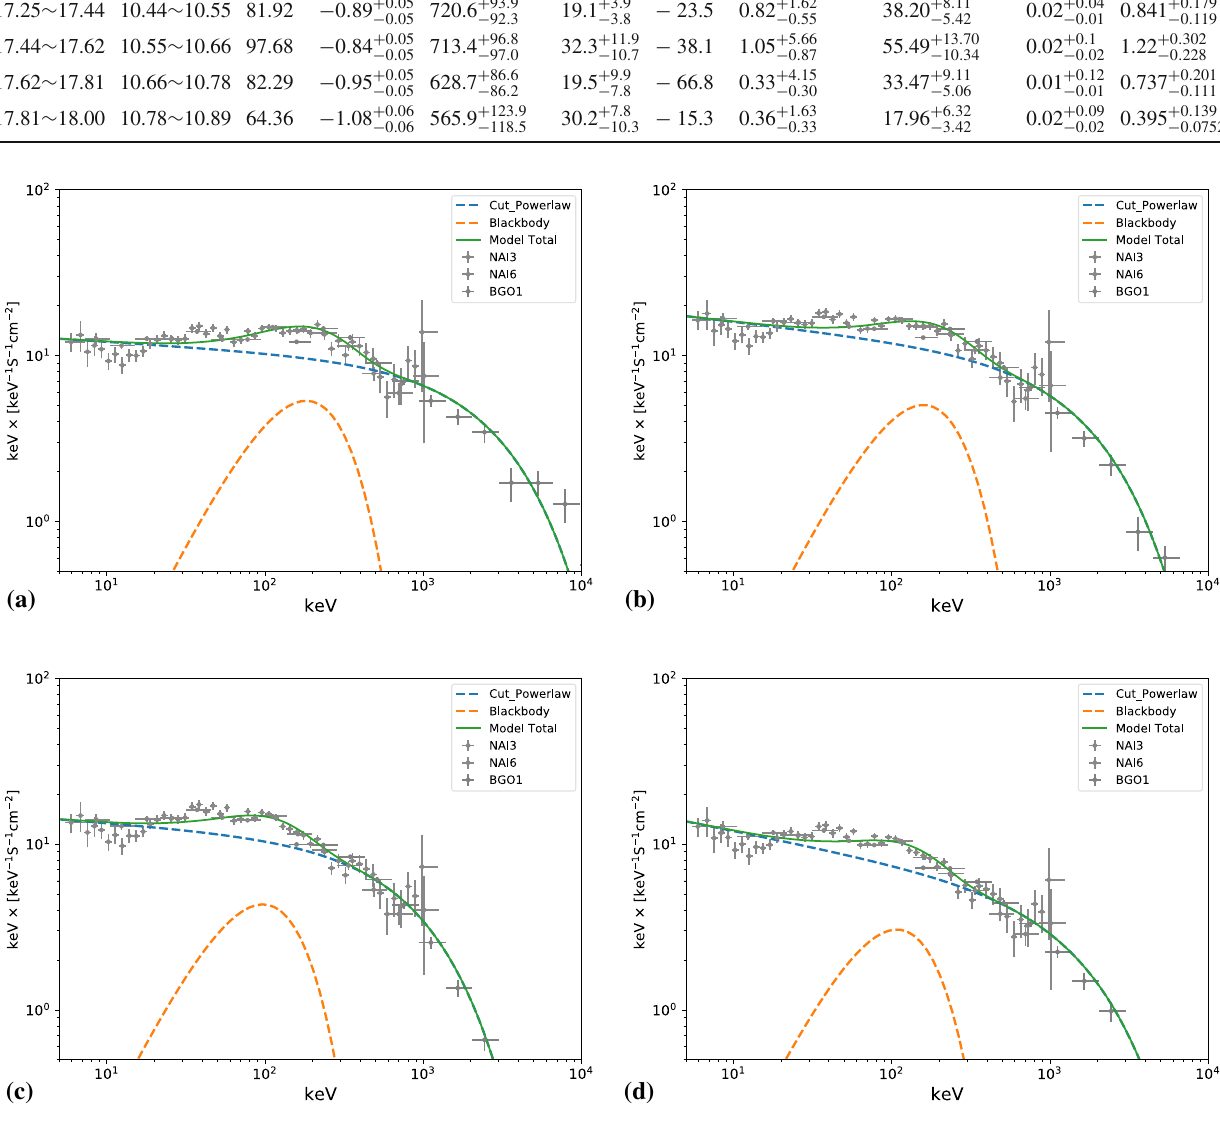
Fig. 3 Time-resolved spectral analysis of the UPE I phase of GRB 180720B. This phase, extending from t rf = 4 . 84 to t rf = 6 . 05, is divided into four time intervals with duration of Δ t rf ≈ 0 . 3 s. The spectra of the best fit for the rest-frame time intervals [4 . 840s–5 . 142s],